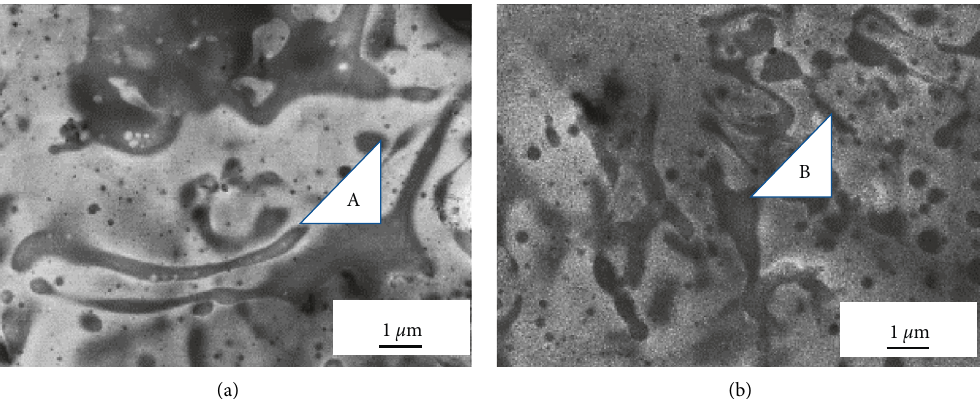
Figure 10: The liquid-phase separation process of Cu55Cr45 alloy during vacuum breakdown. (a) Vacuum induction melting. (b) Mechanical alloying+hot pressing sintering [19].